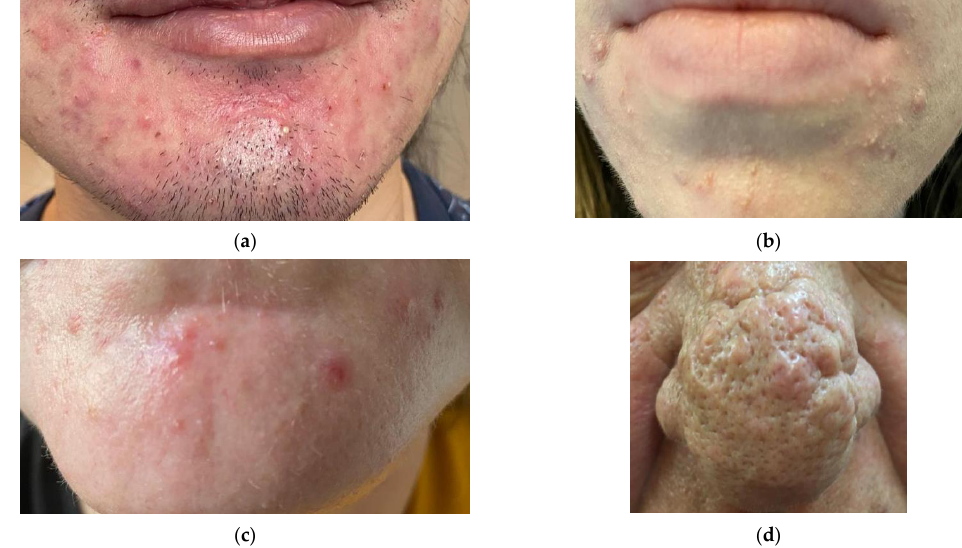
Figure 3. Dermatological manifestations of demodicosis in adults (authors’ own archive): ( a ) Patient with acute skin lesions (rosacea); ( b ) patient with cutaneous demodicosis and bacterial co-infection ( S. aureus ); ( c ) patient with single skin lesions; ( d ) patient with typical skin lesions caused by Demodex spp. on the nose, so-called “Demodex nose”.